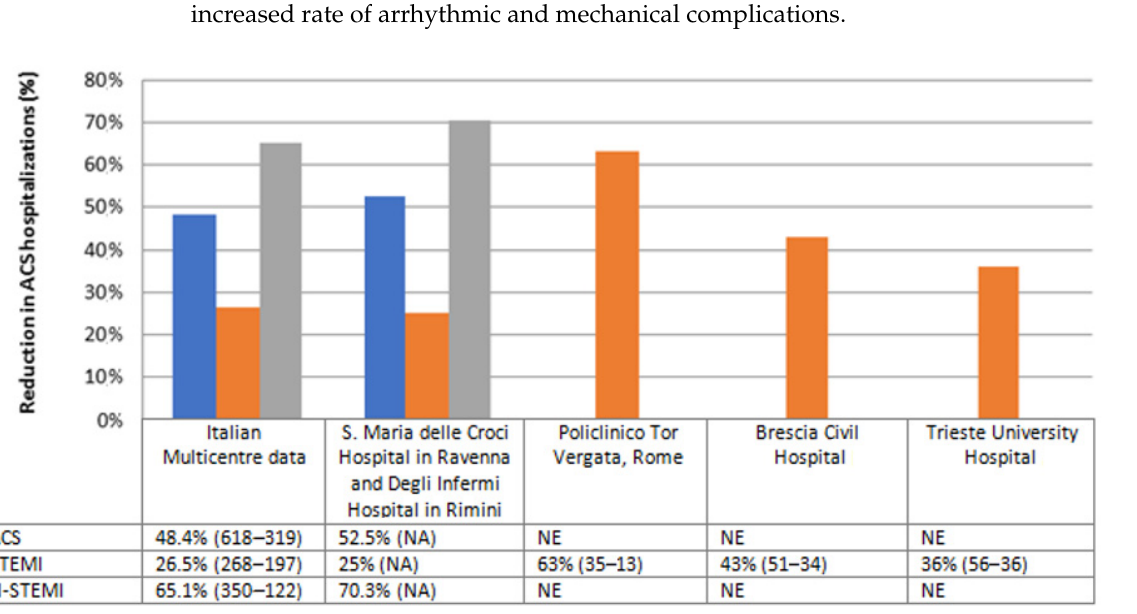
Figure 2. The graph shows the comparison between data relating to ACS hospital admissions in the COVID-19 era and those relating to a previous control period in different Italian hospitals. Reported data refer to Italian Multicentre study [13], a study performed in S. Maria delle Croci Hospital in Ravenna and Degli Infermi Hospital in Rimini [14], Policlinico Tor Vergata [15], Brescia Civil Hospital [16] and Trieste University Hospital [17]. Each cell shows the percentage reduction in hospital compared to the pre-pandemic period, followed respectively by ACS absolute number in the pre-COVID 19 and COVID 19 era (data in brackets). ACS: Acute Coronary Syndrome. STEMI: ST-Elevation Myocardial Infarction. N-STEMI: Non-ST-Elevation Myocardial Infarction. NE: Not evaluated. NA: Not